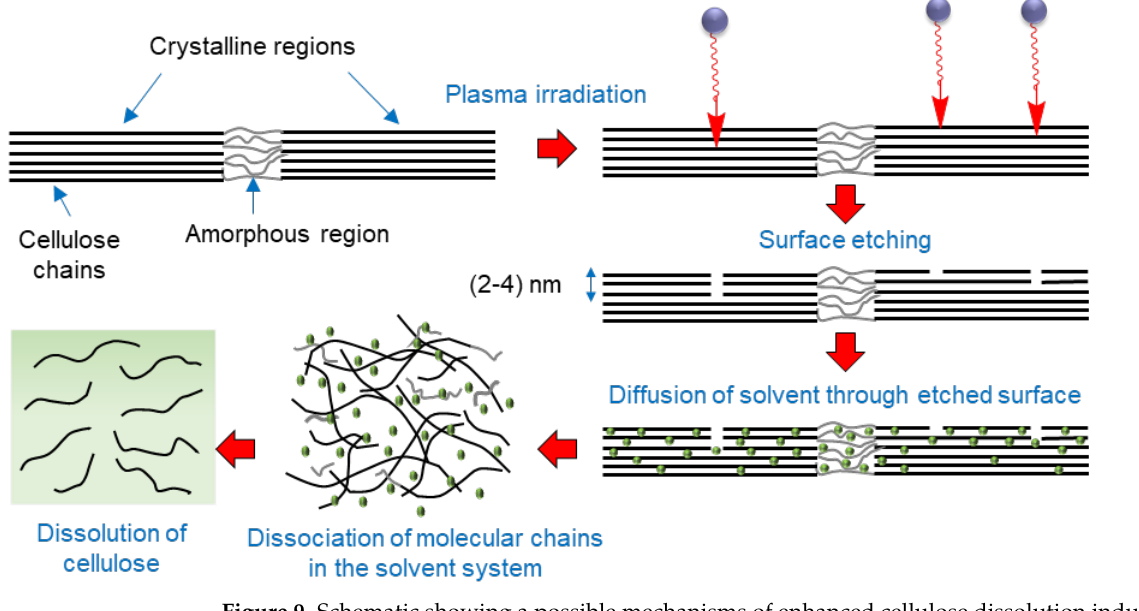
Figure 9. Schematic showing a possible mechanisms of enhanced cellulose dissolution induced by oxygen plasma pretreatment of cellulose.